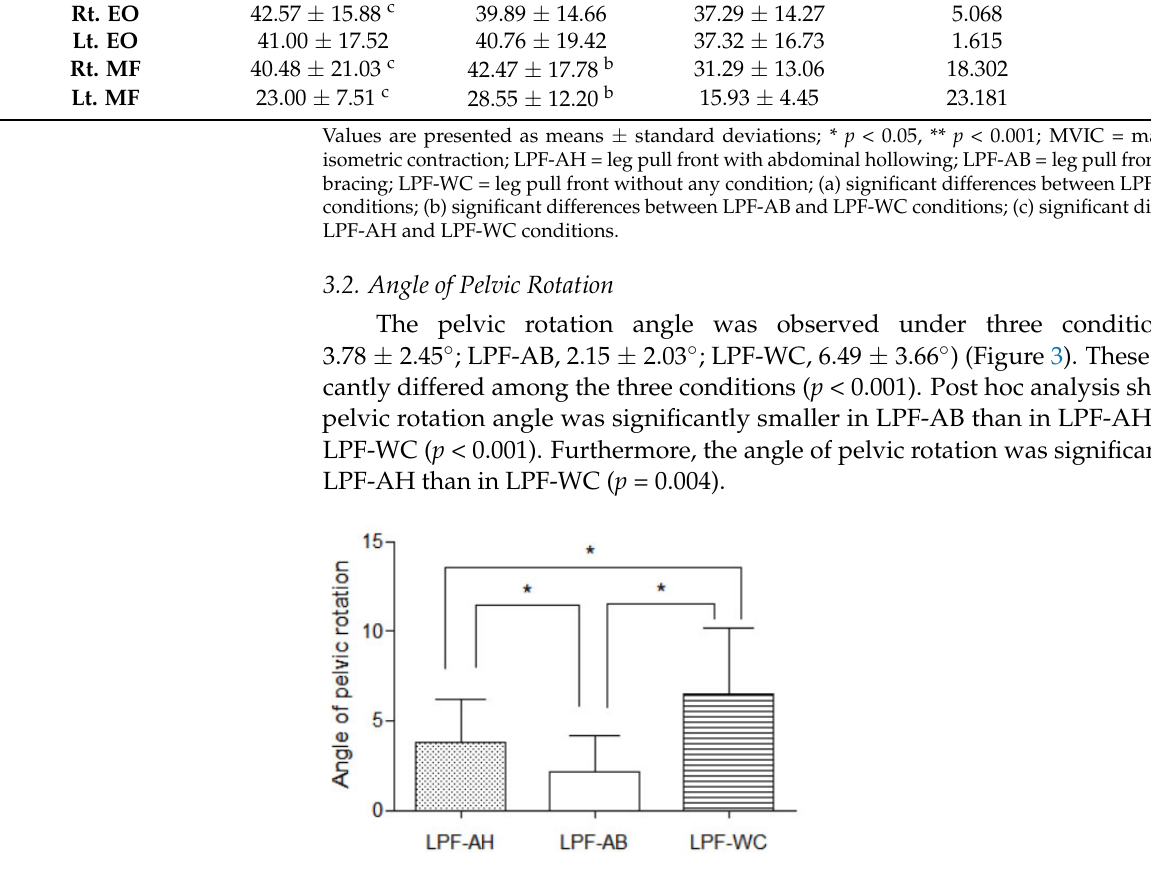
Figure 3. Comparison of the angle of pelvic rotation between the conditions; * p < 0.05; means and standard deviations are denoted by bars,